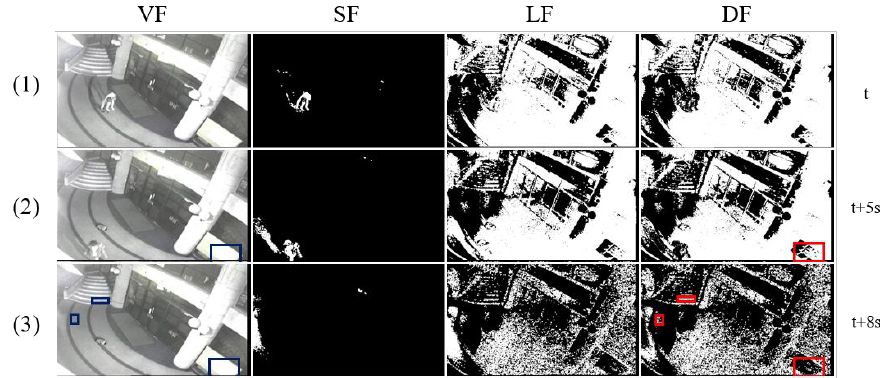
Figure 3. Illumination changes in ABODA video 7 without our illumination change adaptation technique .